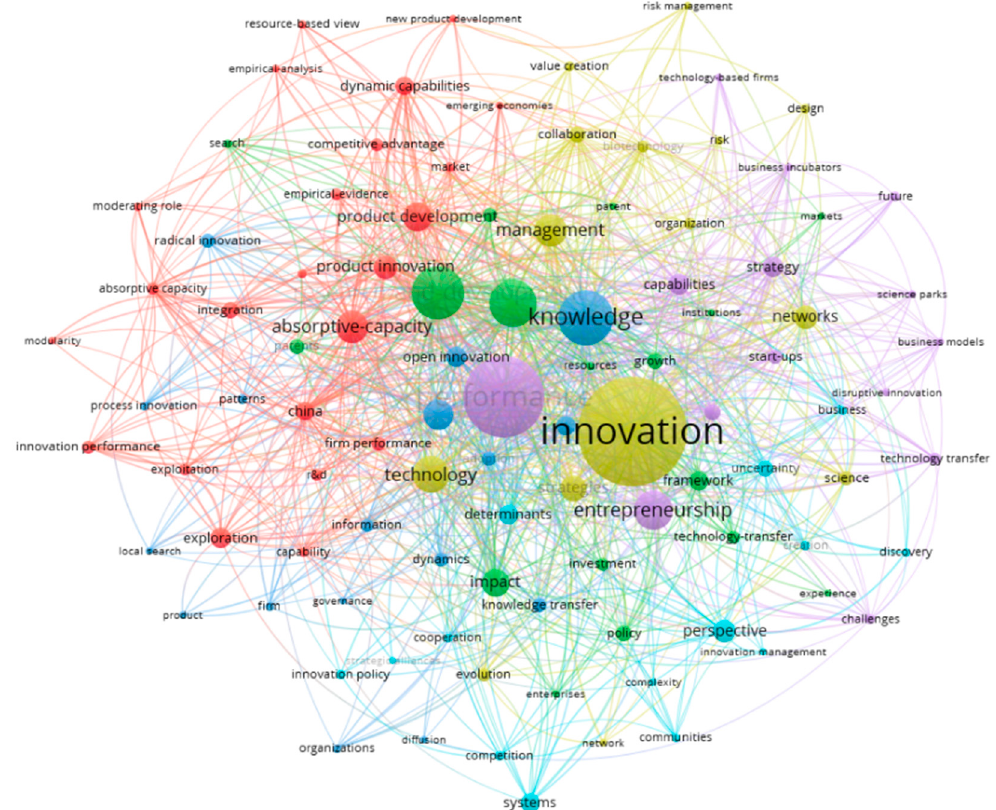
Figure 2. VOS Viewer: keywords from the Technovation Journal. There were six clusters detected in this journal; the total number of keywords was